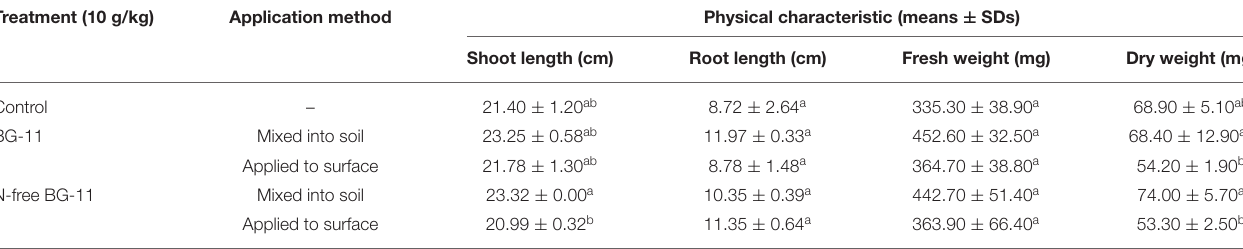
TABLE 4 | Effects of different BG-11 media and application methods on the physical characteristics of rice seedlings.